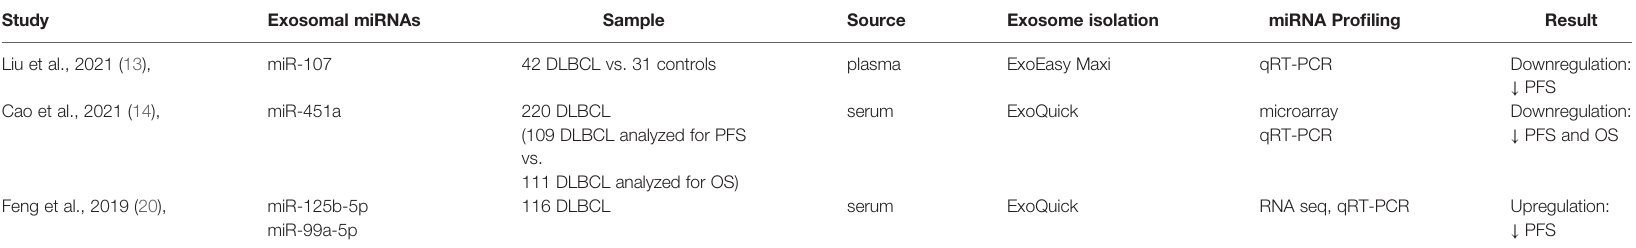
TABLE 4 | Exosomal miRNAs as prognostic biomarkers in DLBCL.